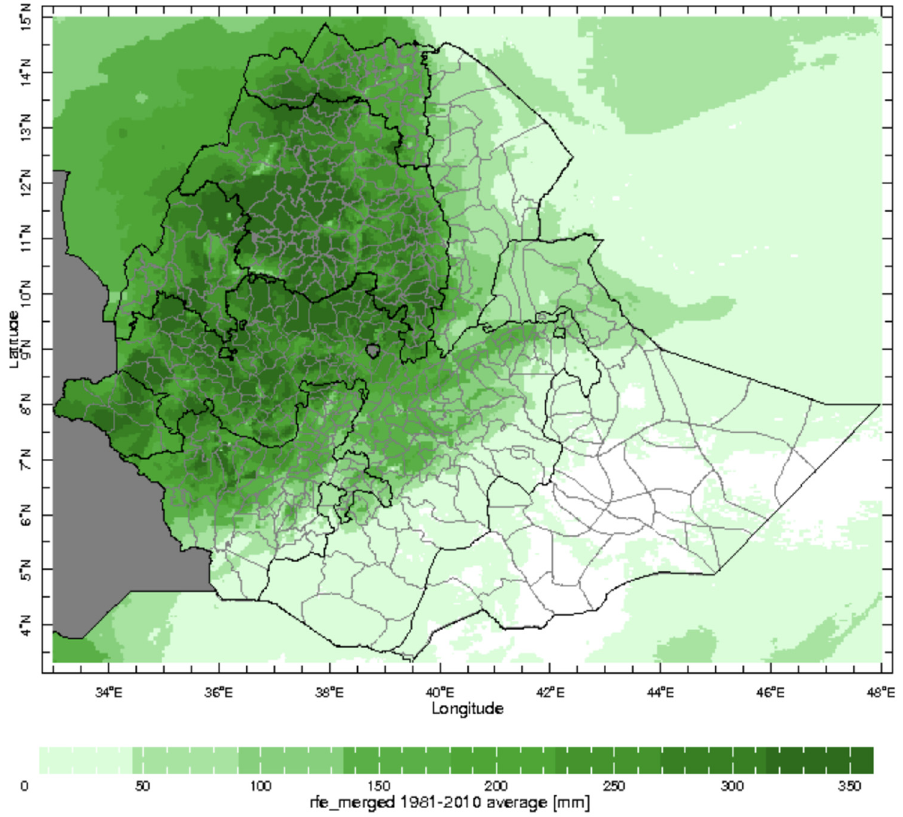
Figure 4. An example of the “Climate Analysis” maproom for Ethiopia.